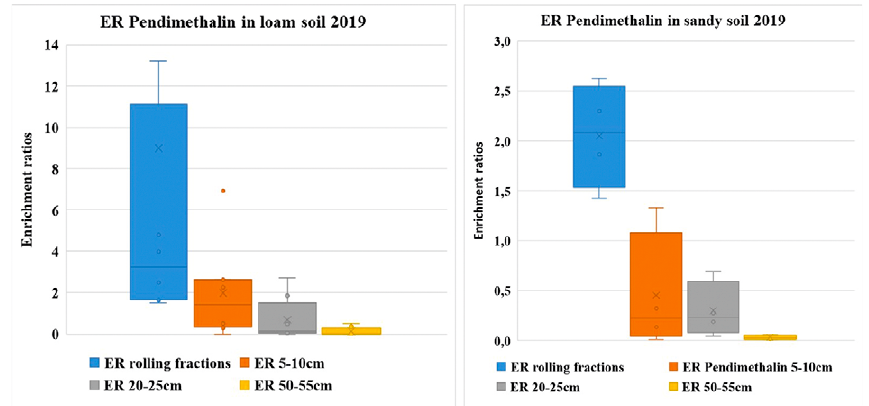
Figure 11. Enrichment of pendimethalin in the texture of loam and sandy soil in